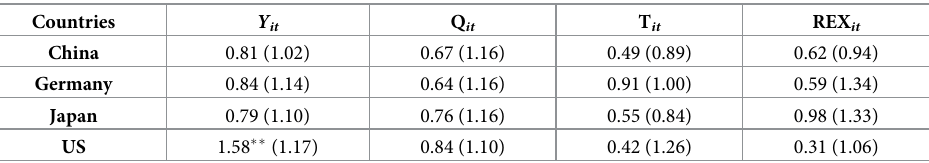
Note �� indicates the rejection of the null hypothesis in which parameters are not stable at a 5% level of significance. The critical values in Figure (.) are the GVAR model-calculated critical values.